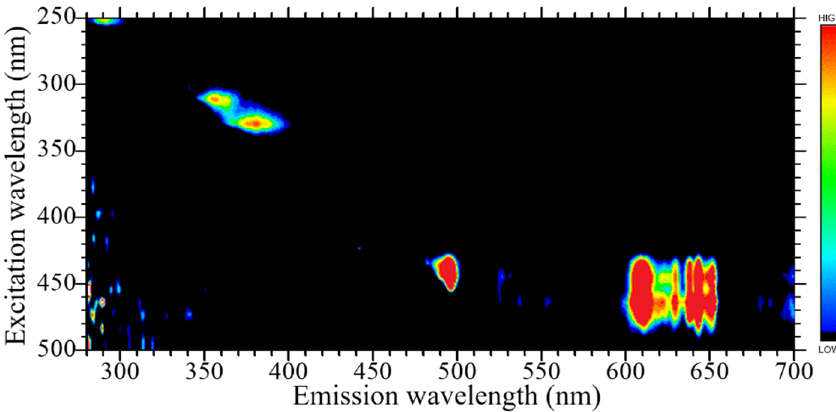
Figure 4. PL emission contour map of the 3.0% Pr-doped LaPS sample. The horizontal and vertical axes show emission and excitation wavelengths, respectively.